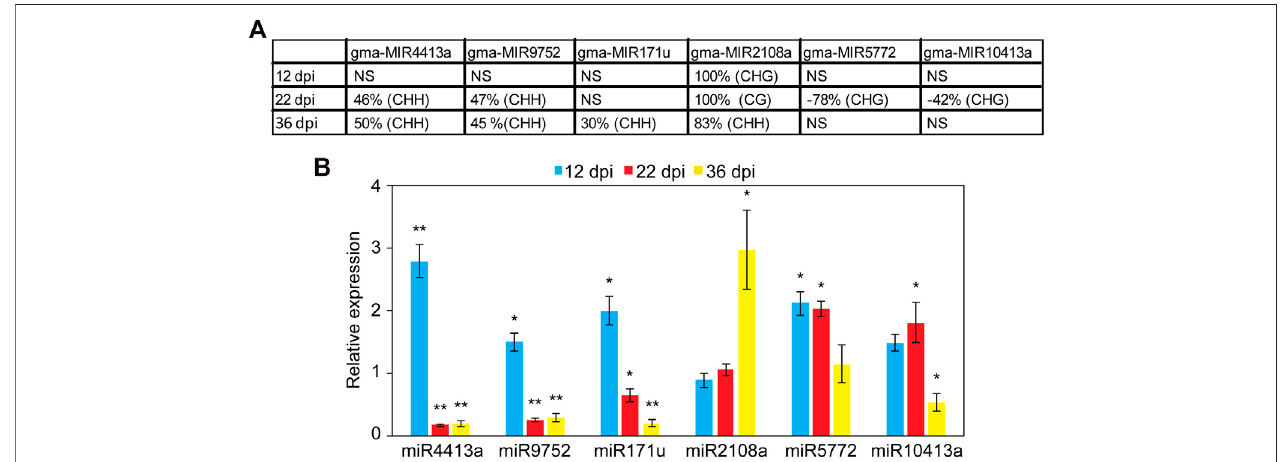
FIGURE 4 | Analysis of the expression levels of promoter hyper- and hypomethylated miRNAs in nodules and root tissues. (A) : DNA methylation levels of six selectedmiRNAsshowinghyperorhypomethylationonlyinthepromoterregionatdifferentnoduledevelopmentalstages. Positivevaluesindicatehypermethylationand negative values indicate hypomethylation. NS, not signi fi cant. (B) : Impact of promoter hyper and hypomethylation on the expression of miRNA genes in the developing nodules. The expression levels of miR2108a (hypermethylated at all time points), gma-miR4413a, gma-miR9752 (hypermethylated at 22 and 36 dpi), gam- miR171u (hypermethylated at 36 dpi), gma-miR5772, and gma-miR10413a (hypomethylated at 22 dpi) were quanti fi ed using qRT-PCR in nodules and roots tissues at 12, 22, and 36 dpi. Fold change values denote expression levels in nodules samples relative to the corresponding control root samples, which were set to 1. Data are averageofthreebiologicallyindependentsamples ± SE.Statisticallysigni fi cantdifferencesfromtherootcontrolsampleswerecalculatedusingttestswith p value < 0.05 and indicated by